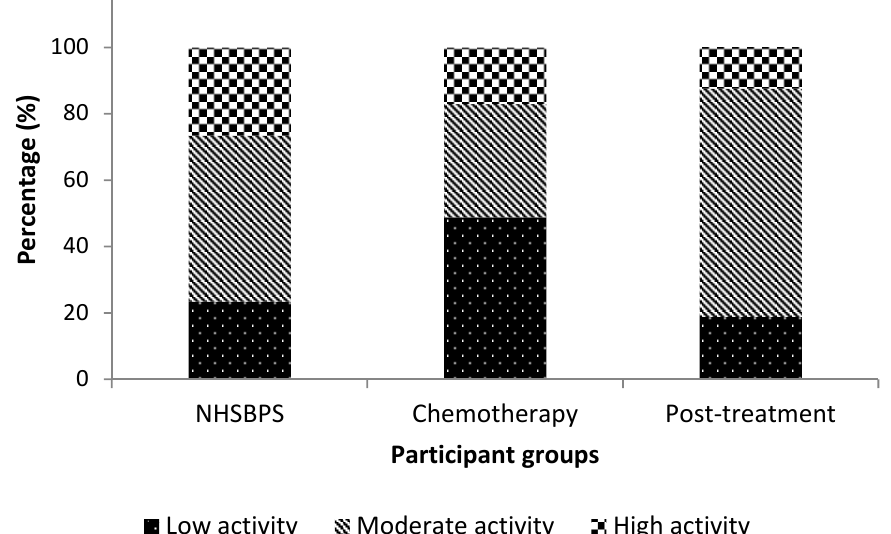
Figure 2. Percentage of participants in each physical activity category in the NHSBPS attendees, chemotherapy breast cancer patients and post-treatment breast cancer